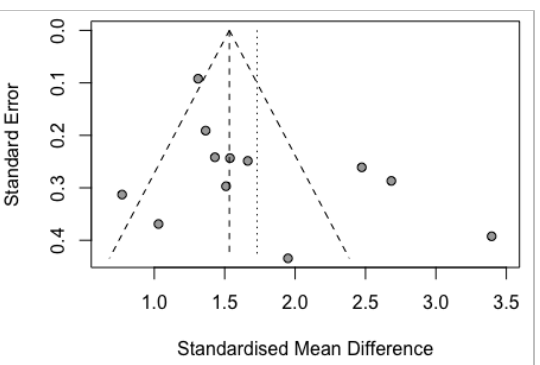
Figure A4. There are a couple of studies outside the confidence bounds for a fixed effect model, including an outlier, but the studies are somewhat balanced on either side of the effect estimates. So, the funnel plot does not reveal an obvious presence of publication or other bias for HC versus MCI_AD.